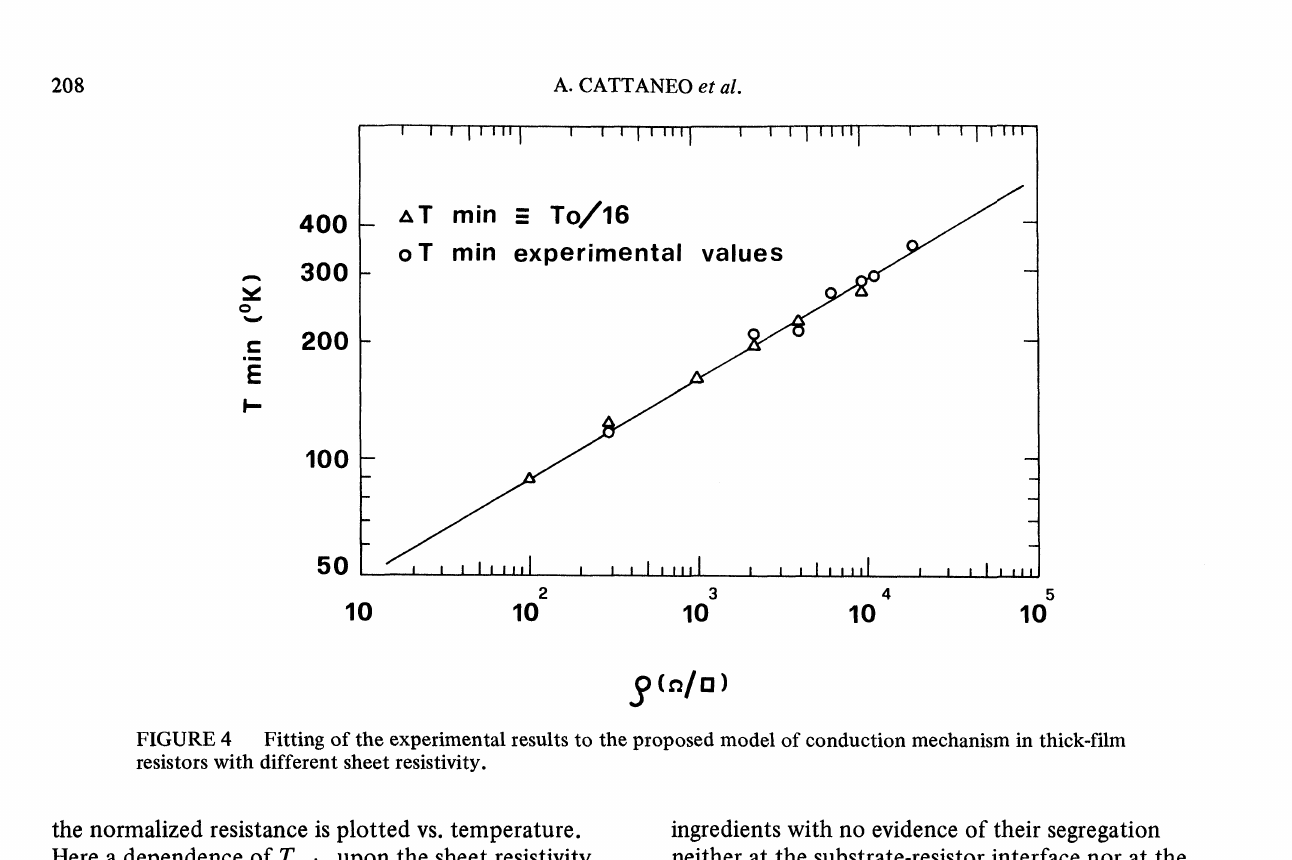
Fitting of the experimental results to the proposed model of conduction mechanism in thick-film resistors with different sheet resistivity. the normalized resistance is plotted vs. temperature.